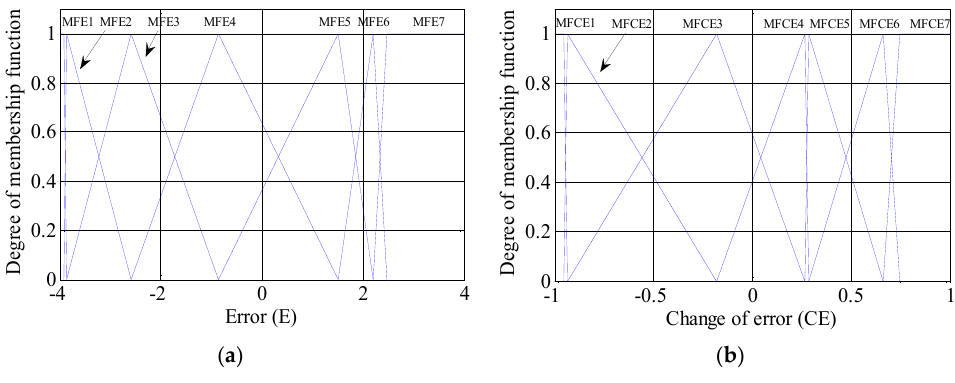
Figure 11. Performance comparisons based on LSA ‐ FL, DSA ‐ FL, and PSO ‐ FL.